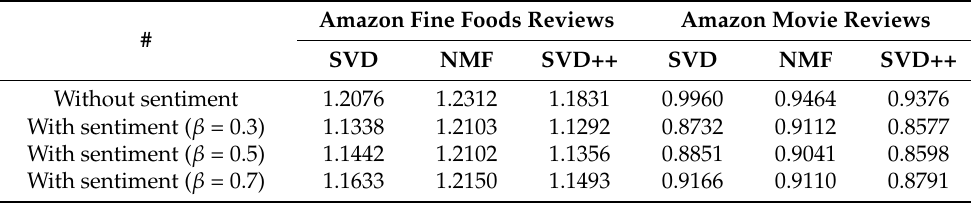
Table 4. RMSE values without and with L-CNN sentiment analysis model.